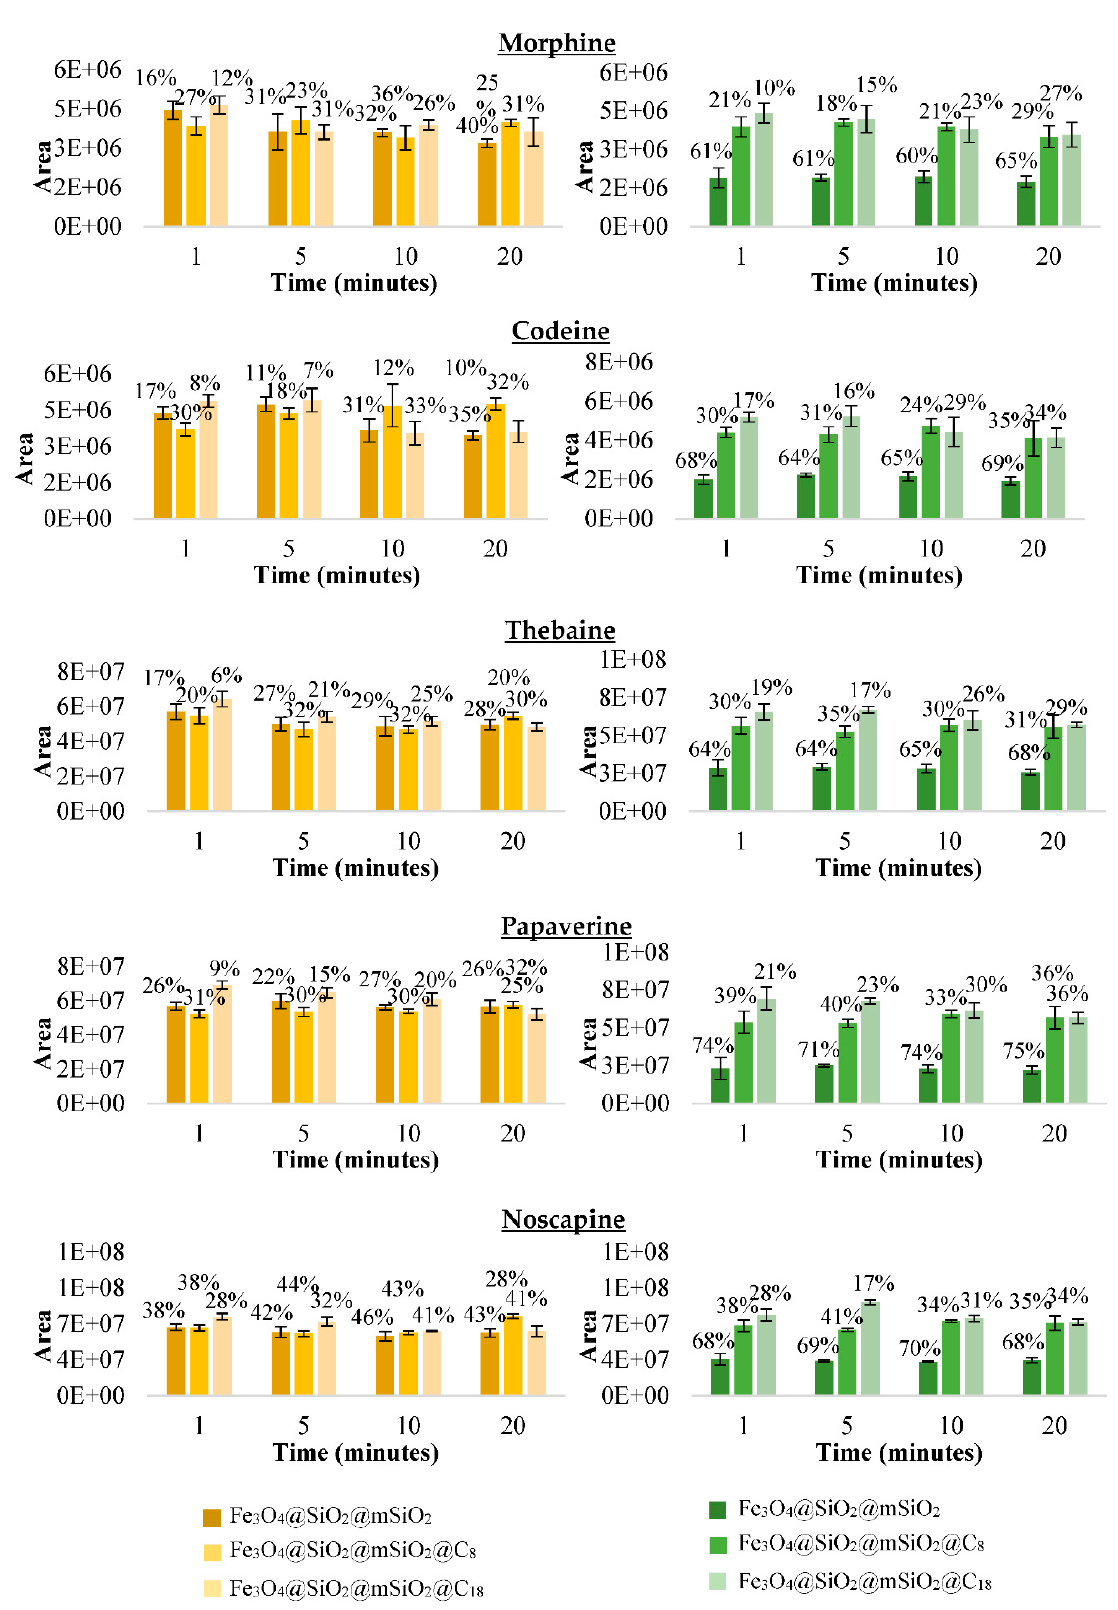
Figure 3. Areas of the supernatant with their respective percentages of adsorption (%) at different times with each of the three mesostructured silica magnetic materials with different adsorption solvent: acetonitrile/water/formic acid 90/19/1 ( v/v/v ) ( yellow colour ) and methanol acidified with 0.1% acid acetic ( green colour ).